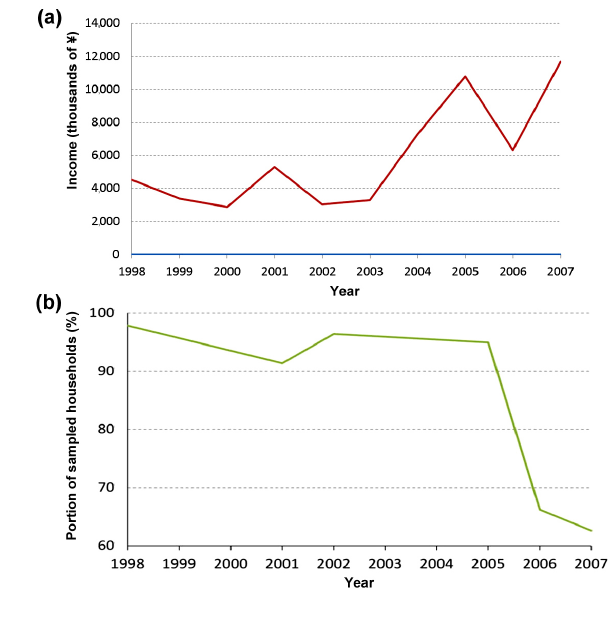
Fig. 6 . (a) Total income from cash crops and livestock in Wolong (discounted to 1998 rates using consumer price index statistics from Sichuan Provincial Bureau of Statistics